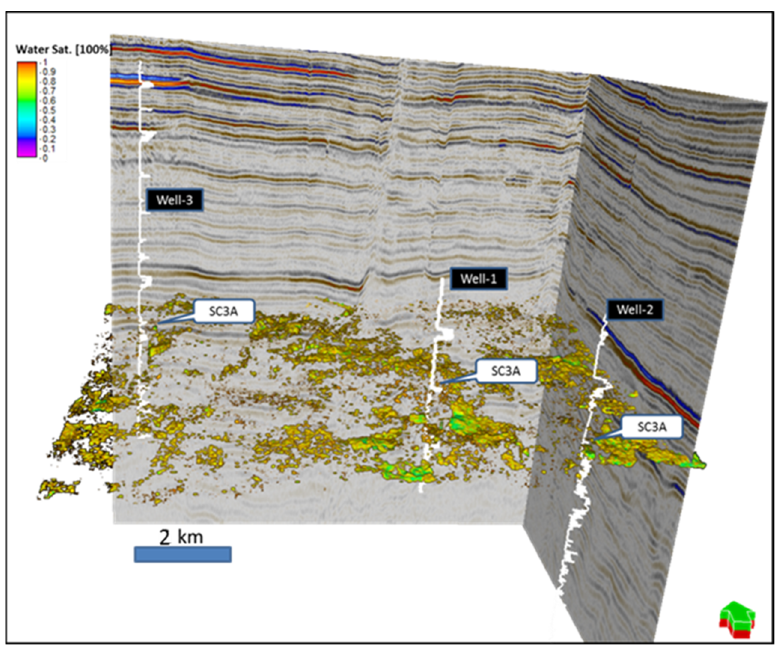
Figure 18. Individual geobody of estimate water saturation of thin gas sand of SC3A pay showing structural con fi rmation with seismic data.